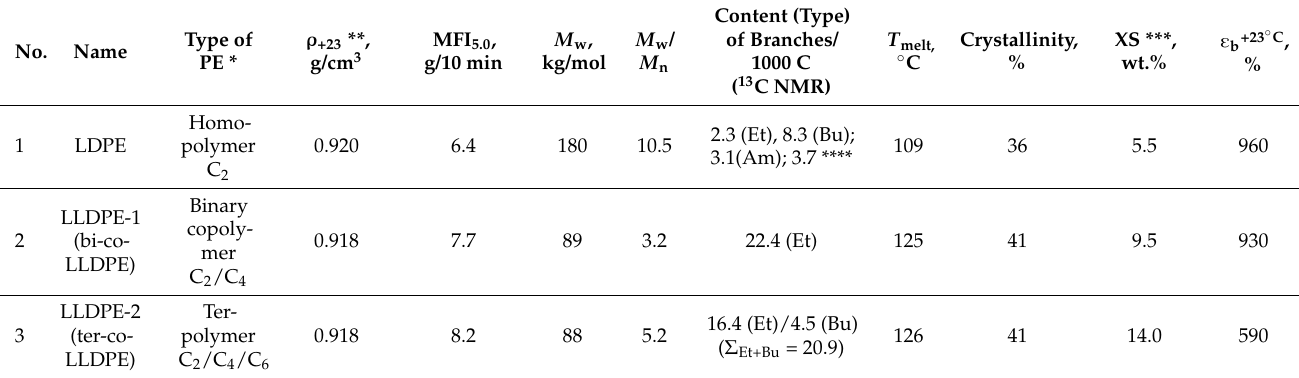
Figure 6. The data on impact strength for the LDPE, LLDPE-1, and LLDPE-2 samples in the tempera- ture range from − 60 ◦ C to +23 ◦ C. Table 5. Characteristics of ethylene polymers having a linear and branched structure.